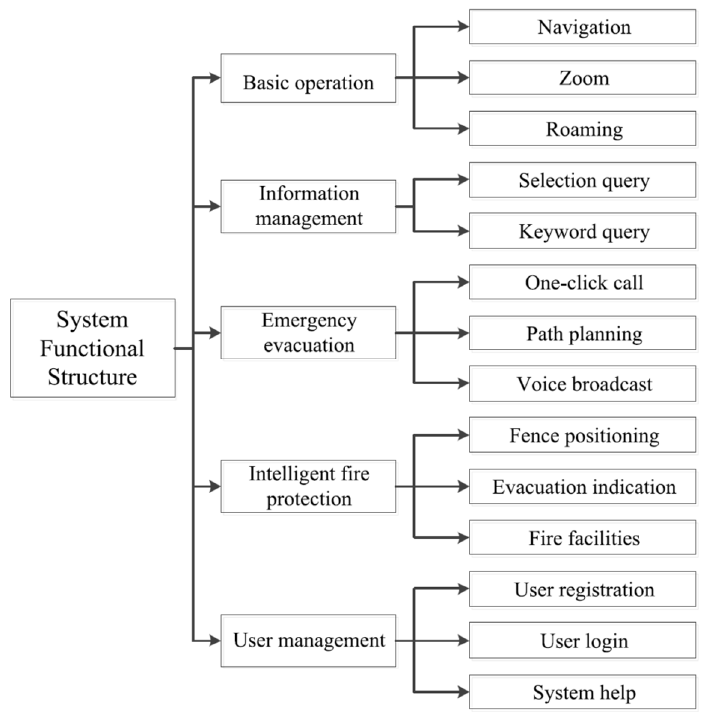
Figure 1. AI system functional structure for fire safety [21].